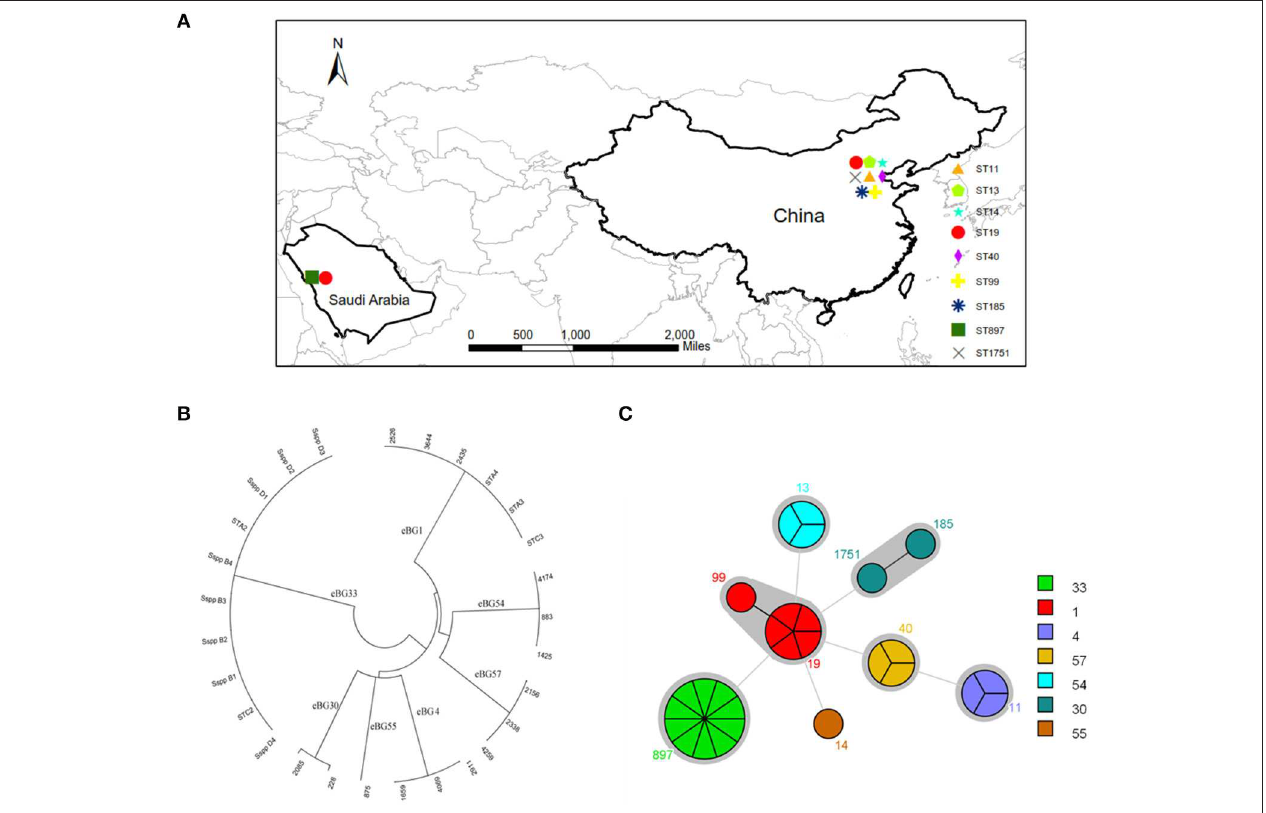
FIGURE 3 | MLST analysis of 28 isolates. (A) The distribution of STs. (B) clonal-complex (CC) (1, 4, 30, 33, 54, 55, and 57) were identified by eBURST analysis. (C) STs and CC.